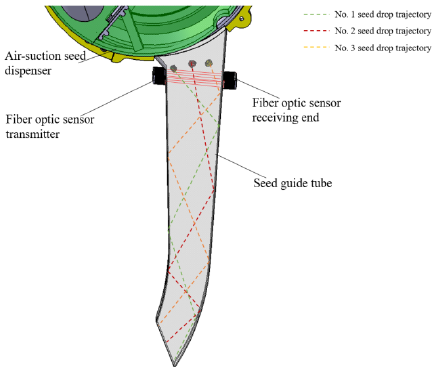
Figure 3. Fiber optic sensor installation diagram.